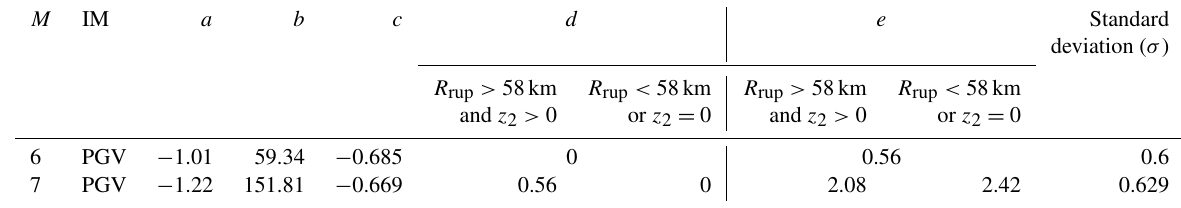
Table 4. Regression coefficients for the attenuation model (AM).